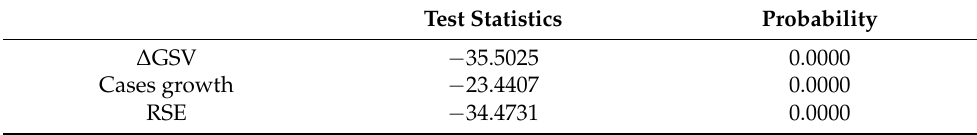
Table A1. Stationarity test.